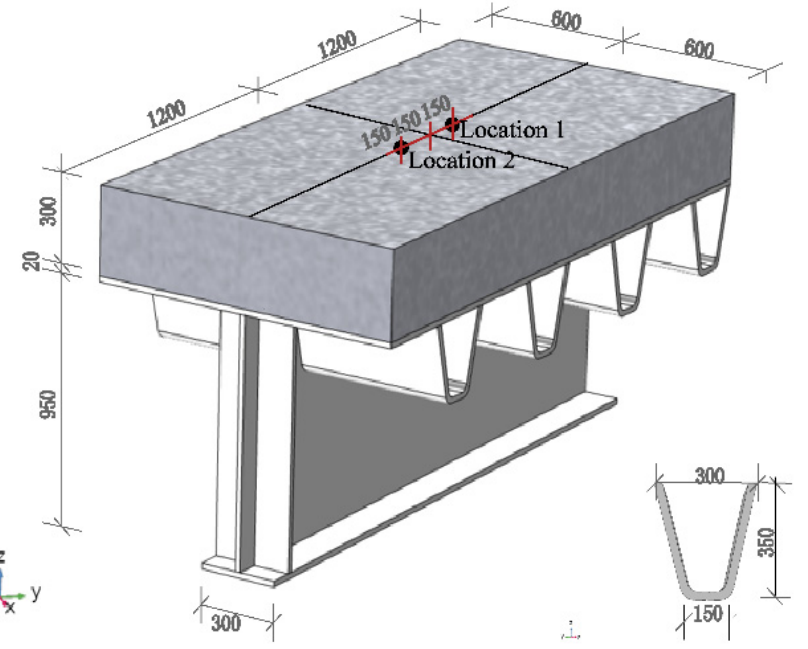
Figure 3. Geometric dimensions and measuring positions of the testing specimen (unit: mm).